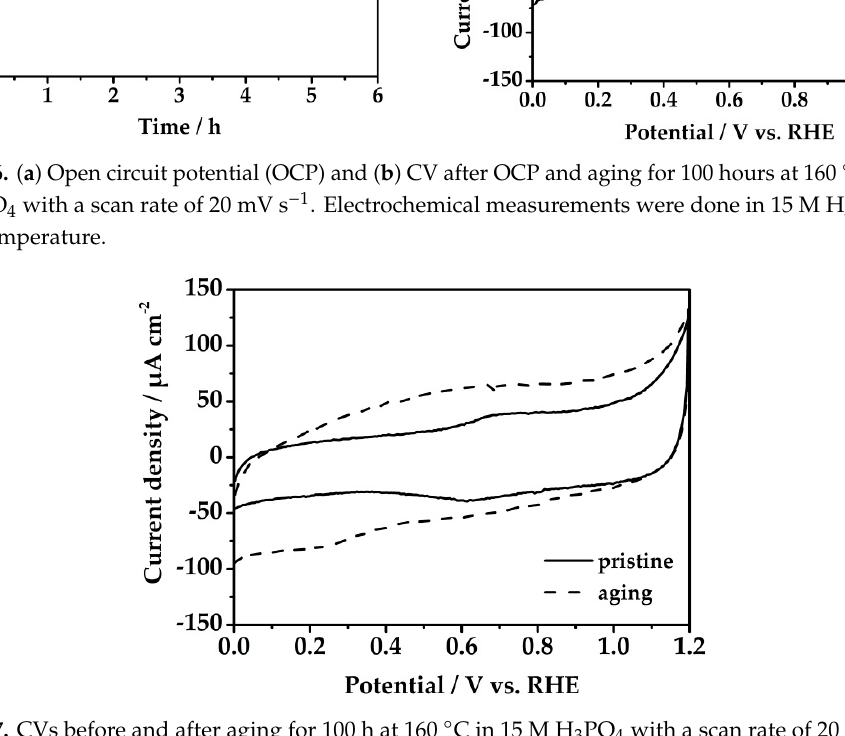
Figure 6. ( a ) Open circuit potential (OCP) and ( b ) CV after OCP and aging for 100 hours at 160 °C in 15 M H 3 PO 4 with a scan rate of 20 mV s − 1 . Electrochemical measurements were done in 15 M H 3 PO 4 at room temperature.